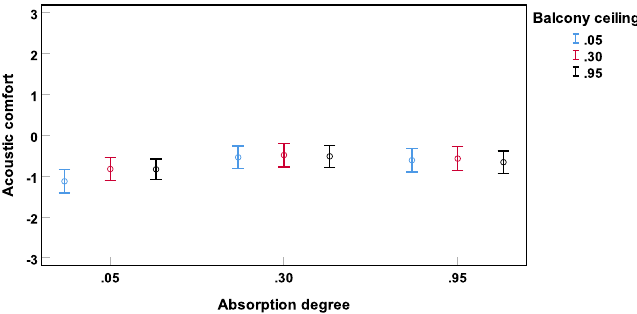
Figure 11. Non-significant interaction (Experiment 3) between α w on the facade and α w on the balcony ceilings. Mean acoustic comfort ratings across subjects and their 95% confidence intervals are